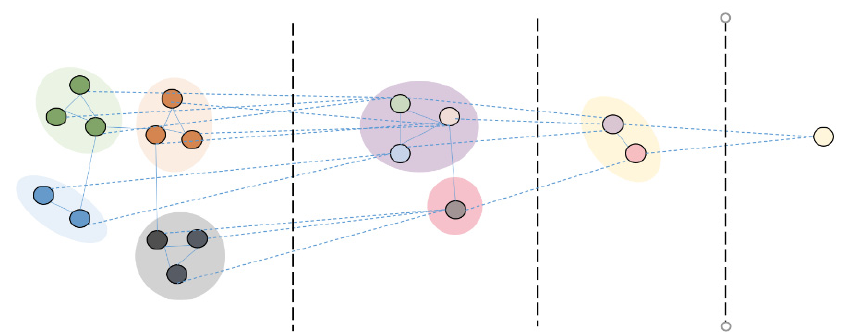
Figure 1. Differentiable pooling